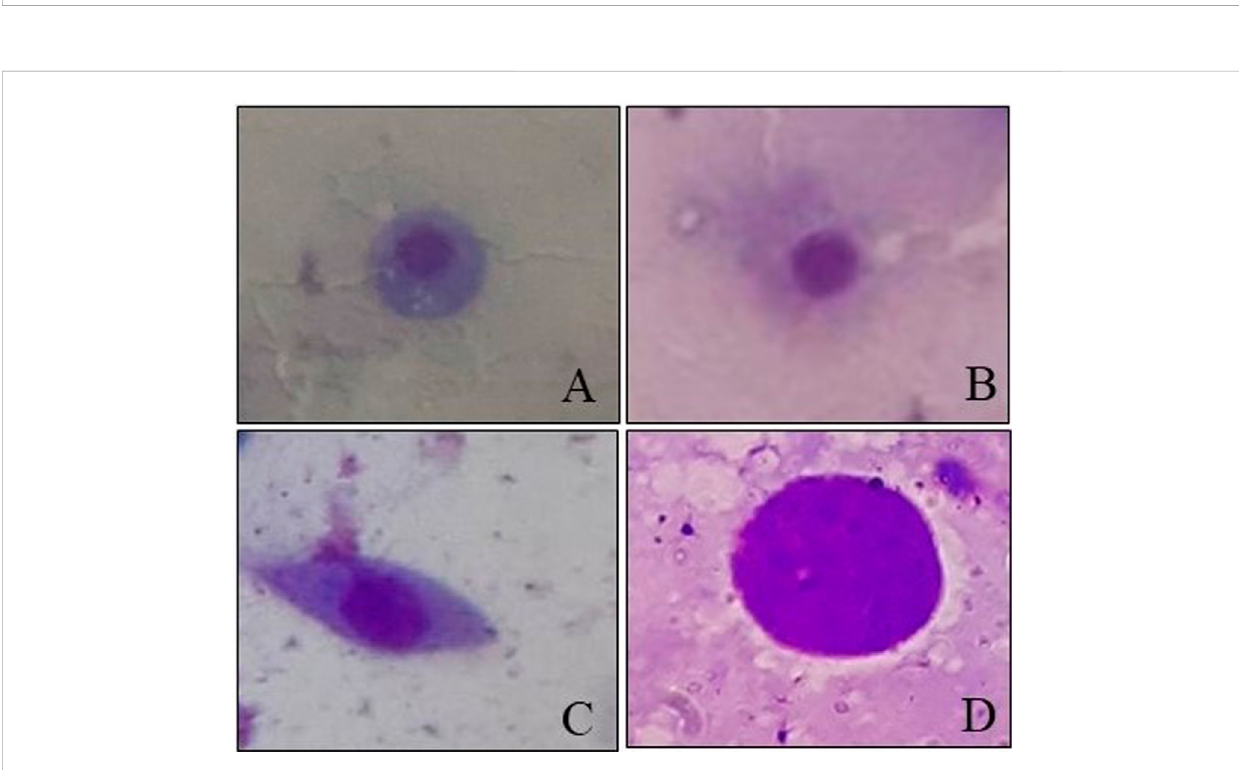
FIGURE 8 Hemocytes observed in worker honey bee larvae. (A) Granulocytes. (B) Permeabilized cell. (C) Spindle-shaped cell. (D) Permeable nucleus.